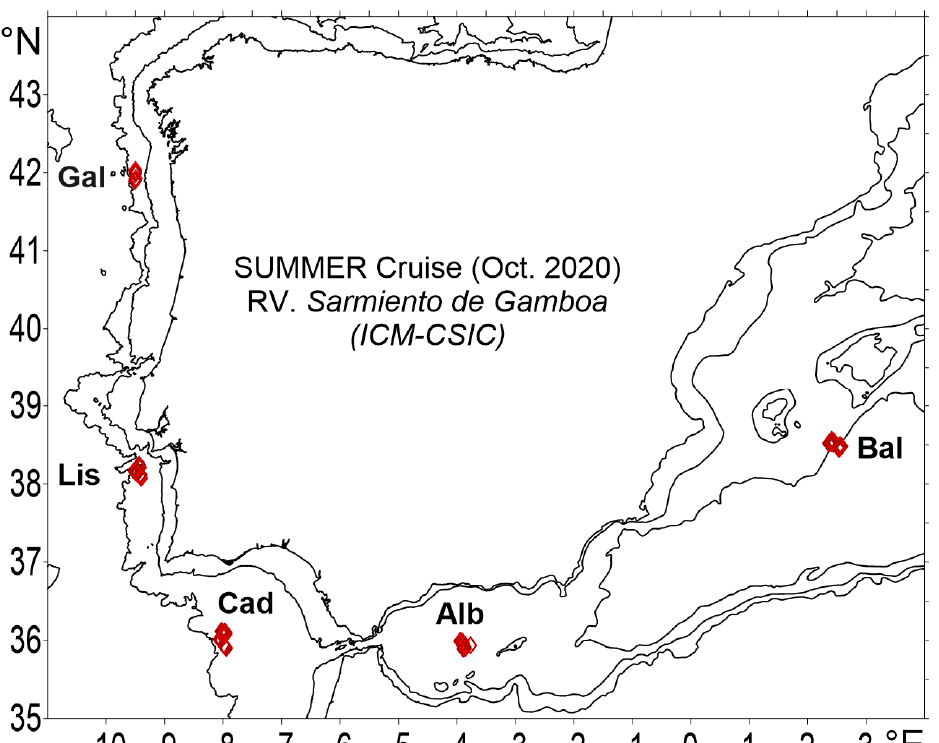
Figure 1. Map of the Iberian Peninsula, surrounded by the western Mediterranean Sea and the northeastern Atlantic Ocean, showing the five sampling areas (Bal: Balearic Sea; Alb: Alboran Sea; Cad: Gulf of Cadiz; Lis: off Lisbon; and Gal: off Galicia). Red diamonds indicate trawling stations with Mesopelagos nets.